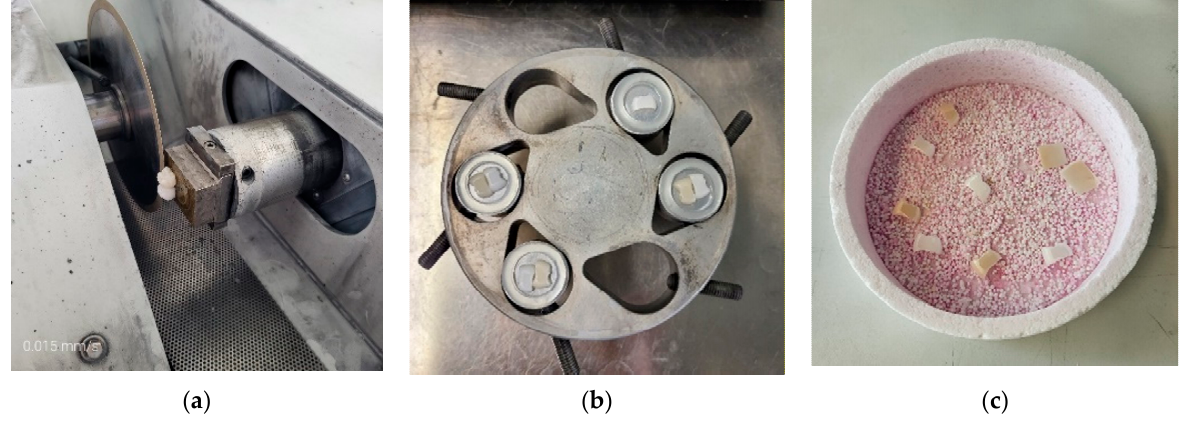
Figure 4. Steps of preparing crowns for thermal etching: ( a ) cutting samples, ( b ) parts of crowns fixed with temporary glue for grinding and polishing, ( c ) finished samples.